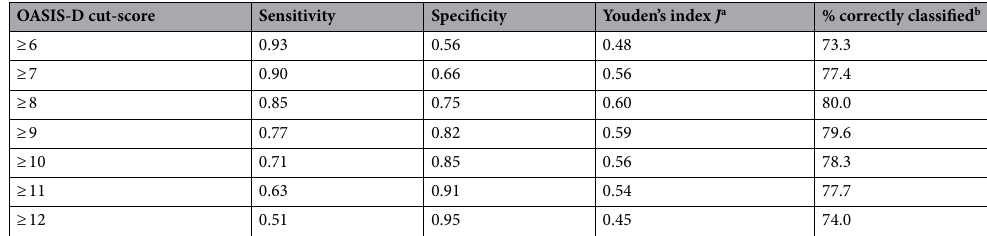
Table 3. Characteristics of possible OASIS-D cut-scores for identification of primary care patients with panic disorder with/without agoraphobia. a Calculation formula: J = sensitivity + specificity − 1. b Overall accuracy computed as the ratio between the number of patients correctly classified as positive or negative cases and the total number of